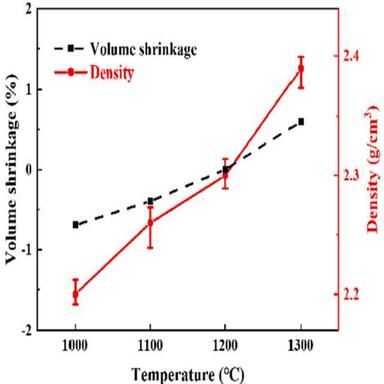
Volume shrinkage and Density of samples with different sintering temperatures.